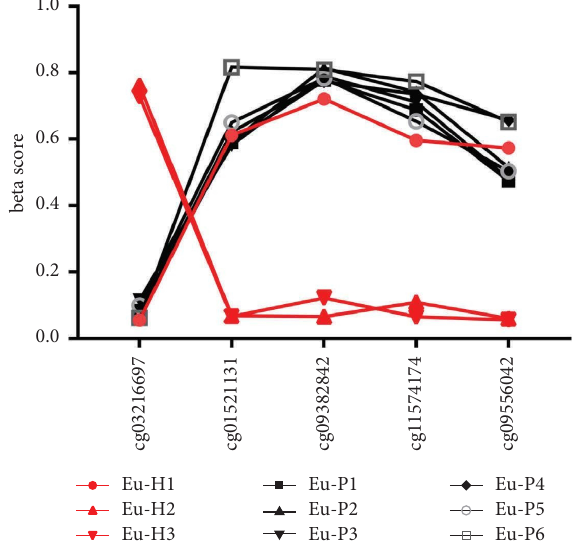
Figure 3: Te beta scores of fve aberrantly methylated 5 ′ –C–phosphate–G–3 ′ sites mapped to the human leukocyte antigen-C (HLA-C) gene in HLA-C ∗ 07 carriers. Following HLA-C genotyping, nine HLA-C ∗ 07 carriers were selected from the 12 participants in the microarray study. Te deoxyribonucleic acid methylation status of the healthy woman (Eu-H1) was identical to that of the patients (Eu- P1–Eu-P6), while the other two (Eu-H2 and Eu-H3) were